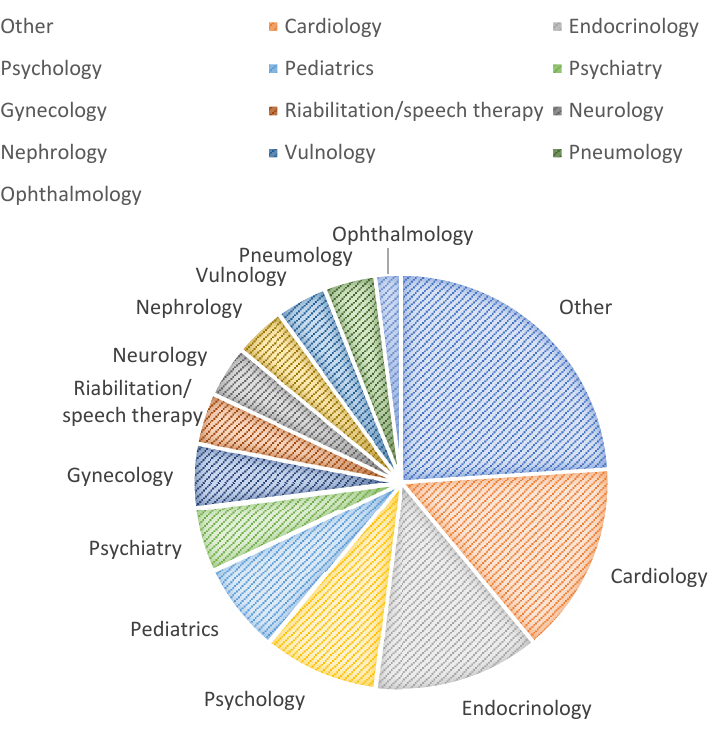
Figure 1. Distribution of telemedicine programs in the Piedmont territory.